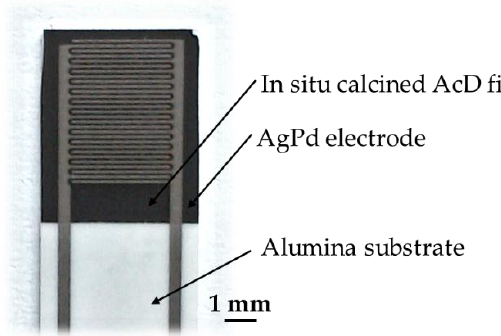
Figure 2. Finished NTCR sensor after completion of multifunctional temperature treatment.